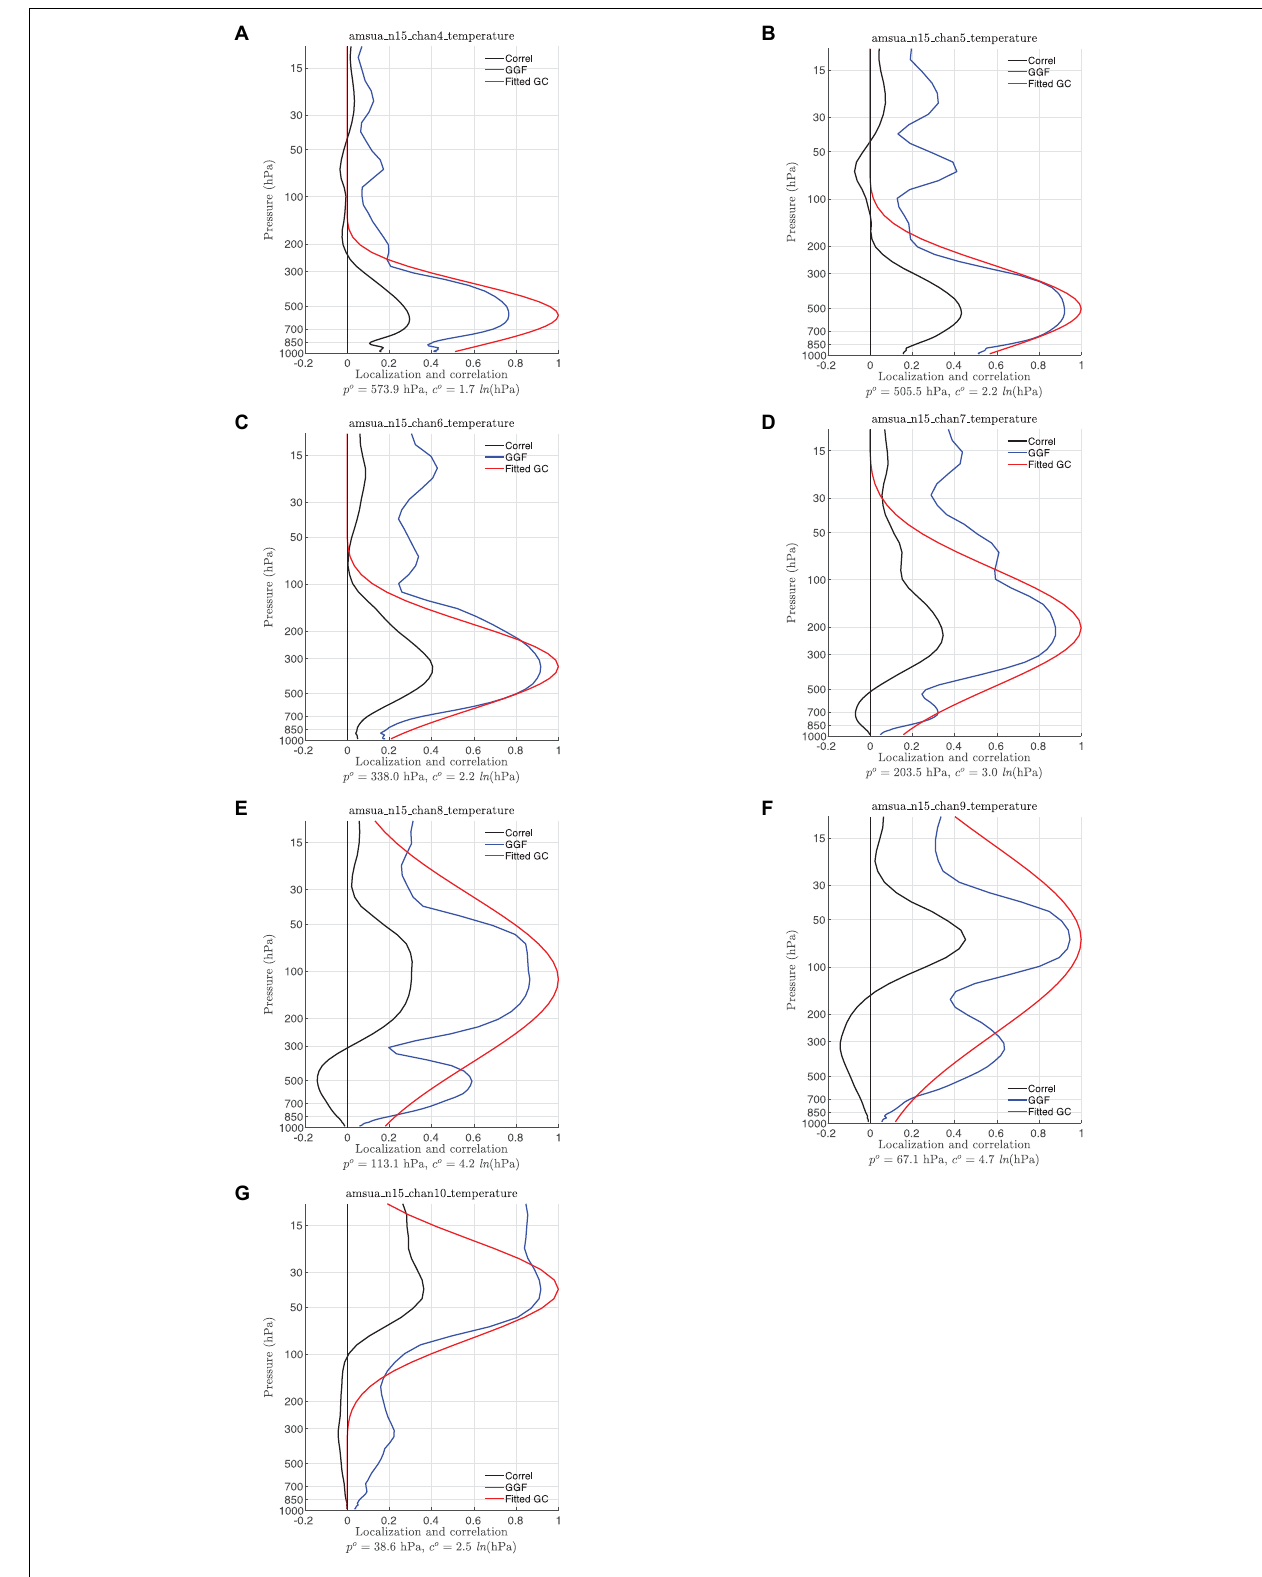
FIGURE 1 | The mean sample correlations (black), estimated GGF localization functions (blue), and fitted GC localization functions (red) for (A–G) channels 4–10 of the NOAA-15 AMSU-A radiances with state variable temperature. The estimated localization parameters p o and c o are denoted at the bottom.